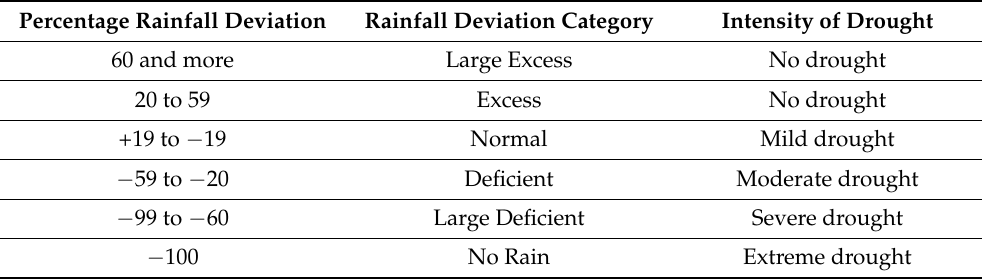
Table 4. Drought intensity based on the percentage departure of rainfall from the normal value given by IMD, 1971. Percentage Rainfall